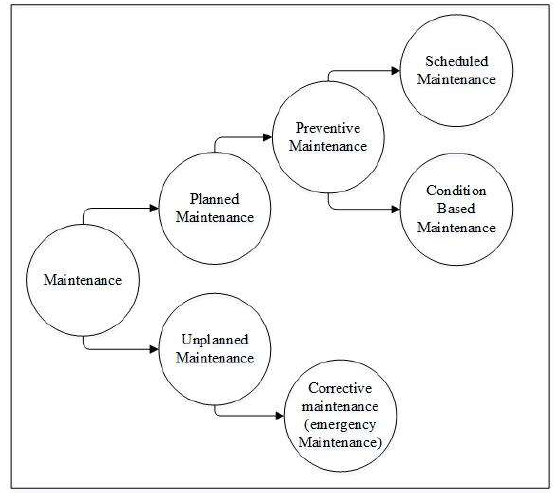
Figure. 1 Categorization of Maintenance